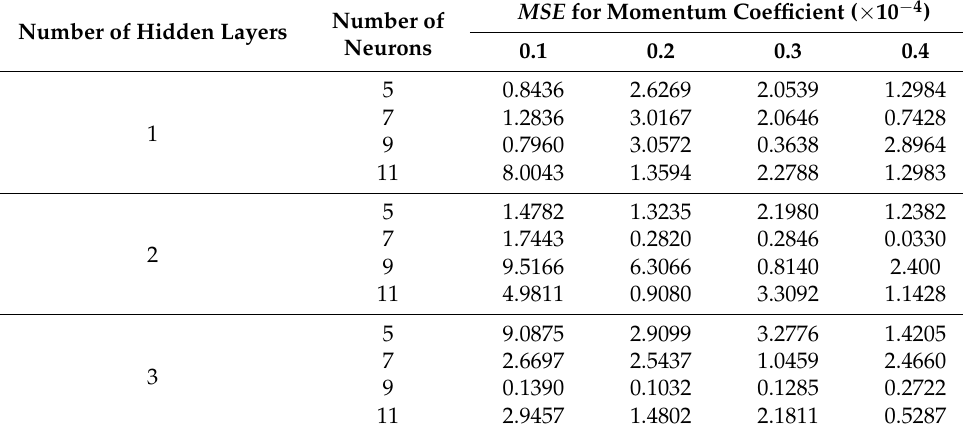
Table 4. Variation in MES values with different ANN configurations.